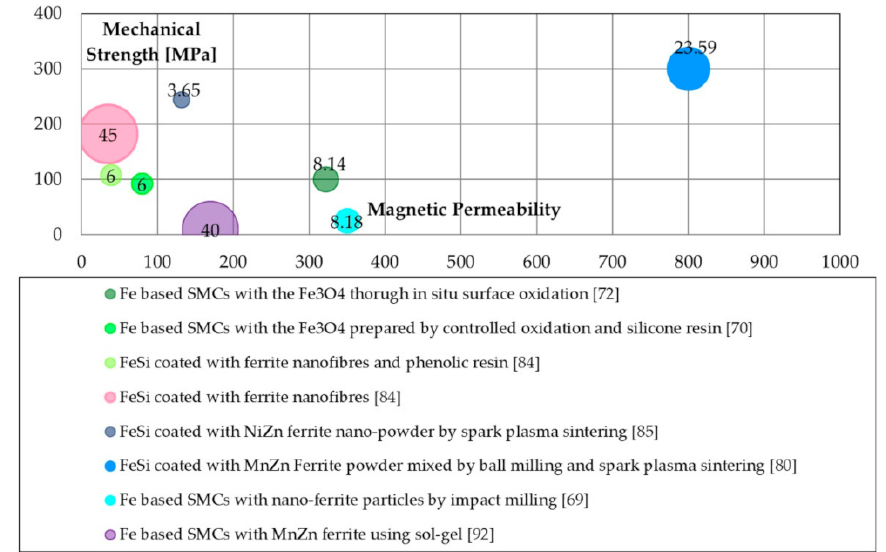
Figure 4. Magnetic (maximum permeability), mechanical (TRS [MPa]), and energetic properties (total iron losses 1 T@50 Hz [W/kg]) of ferrite coating